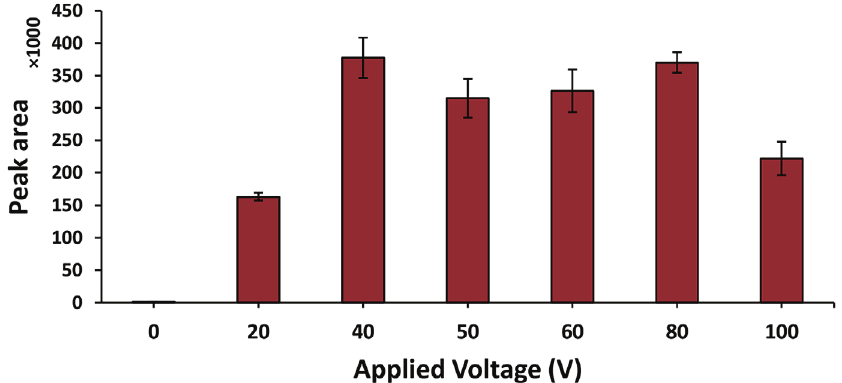
FIGURE 4 - Effect of voltage on EME efficiency (extraction conditions; concentration in donor: 1 µg/mL, SLM: 1-octanol, pH of donor: 9.0, pH of acceptor: 13 and time of extraction: 10 min).